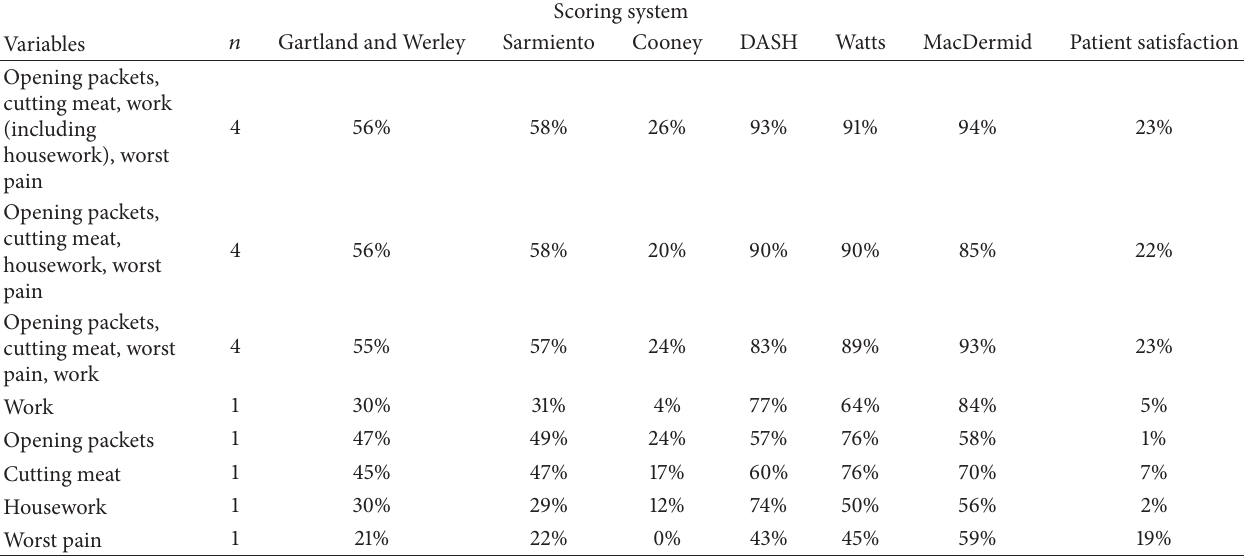
Table 5: Percentage of variation within each scoring system explained by subsets of variables ( 𝑛 = number of